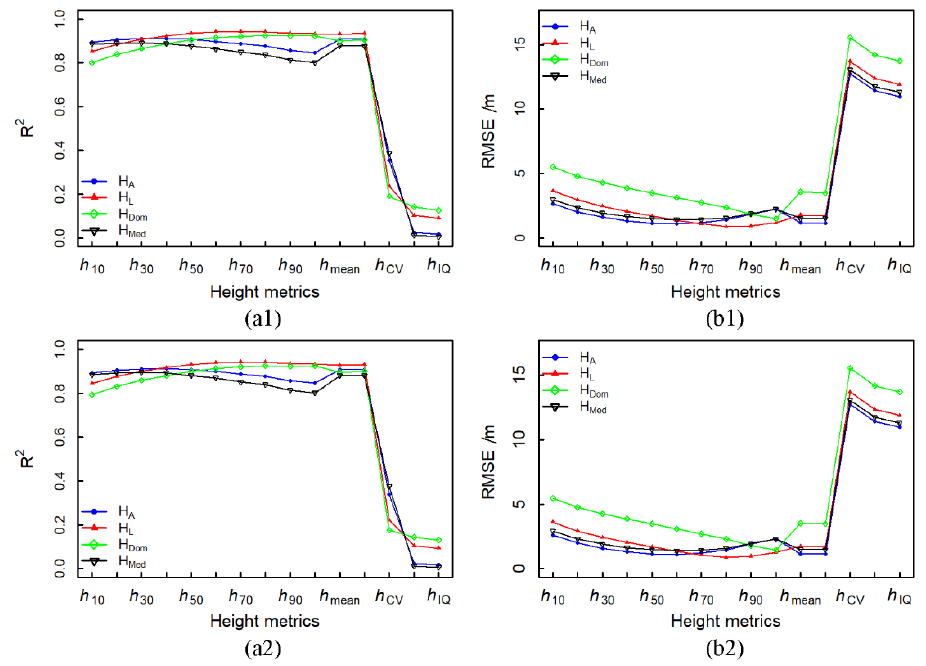
Figure 8. Correlation between the stand heights and height metrics calculated from the P-NPC metrics ( a1 , b1 ) and P-CHM metrics ( a2 , b2 ) for ALL plots. Based on the strong correlations between height metrics and each forest stand height, simple linear regression for H A , H L , H Dom , and H Med using height metrics generated from the ULS and USP datasets was applied to fit each forest stand height. The best explanatory variables for different models, and corresponding modeling accuracy of simple linear regression models using NPC and CHM metrics alone extracted from ULS and USP, respectively, are summarized in Figure 9 and Table